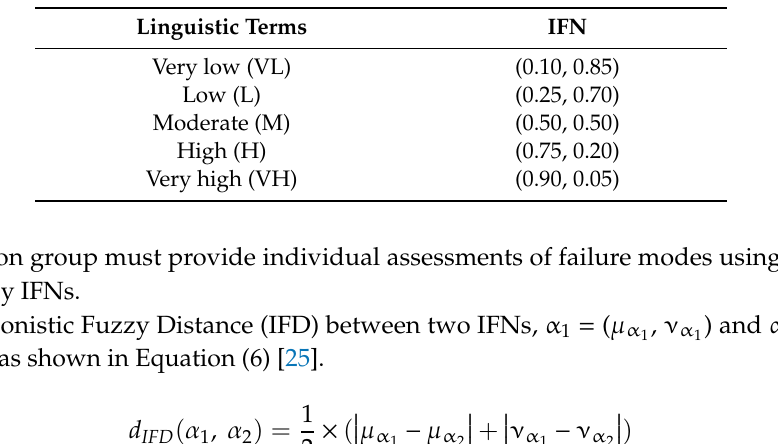
Table 4. Linguistic terms for assessing subjective weights of risk